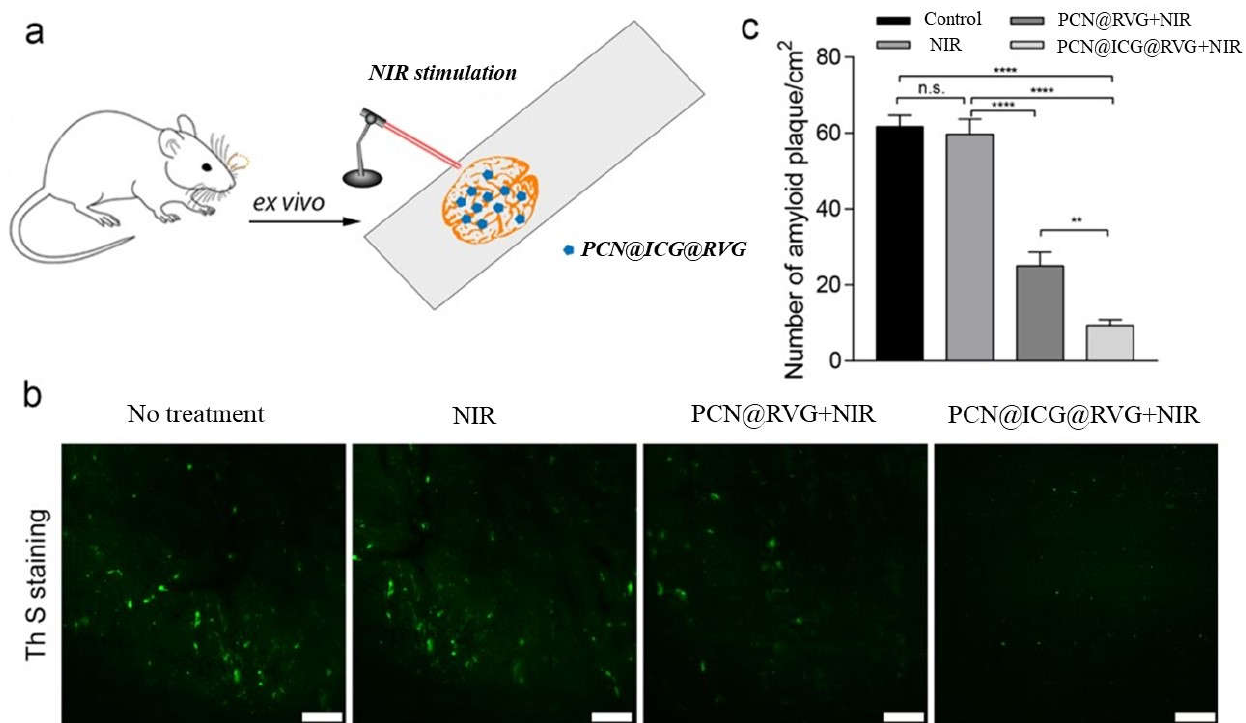
Figure 9. Ex vivo evaluation of NIR-stimulated PCN@ICG nanosheet on mouse brain Aβ plaque dissociation. ( a ) Schematic illustration of NIR-stimulated PCN@ICG nanosheet dissembling Aβ plaques in mouse brain slice. ( b ) Confocal microscopic images of ThS staining of Aβ plaques after different treatments. Scale bars: 50 µm. ( c ) Quantitative analysis of the density of Aβ plaques with different treatments using Image J software (all values were statistically analyzed by means of one-way ANOVA. ** p < 0.01, **** p < 0.0001, n.s. = not significant). Each treatment group contained three technical replicates.